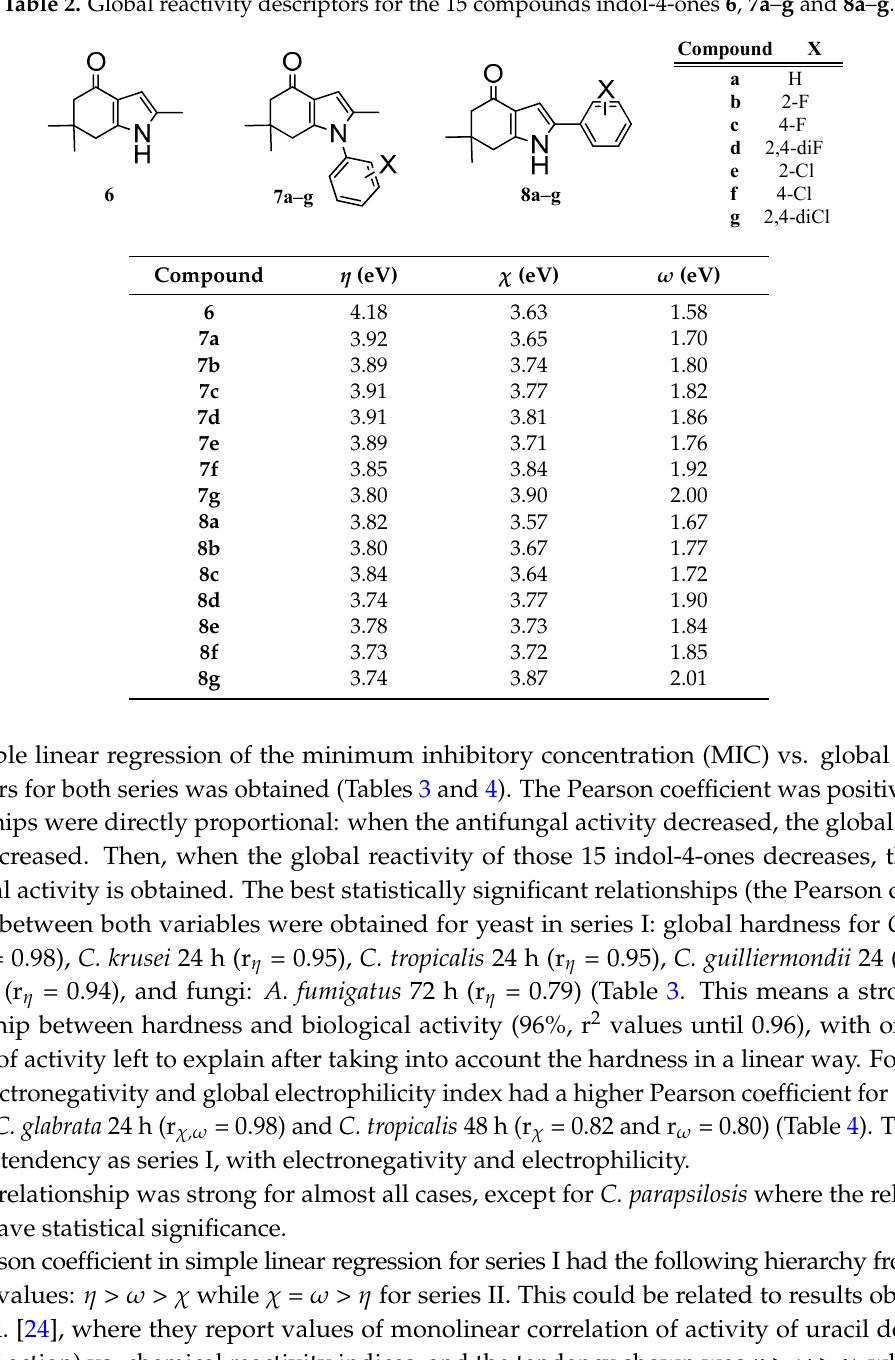
Molecules 2017 , 22 , 427 Table 2. Global reactivity descriptors for the 15 compounds indol-4-ones 6 , 7a – g and 8a – g .